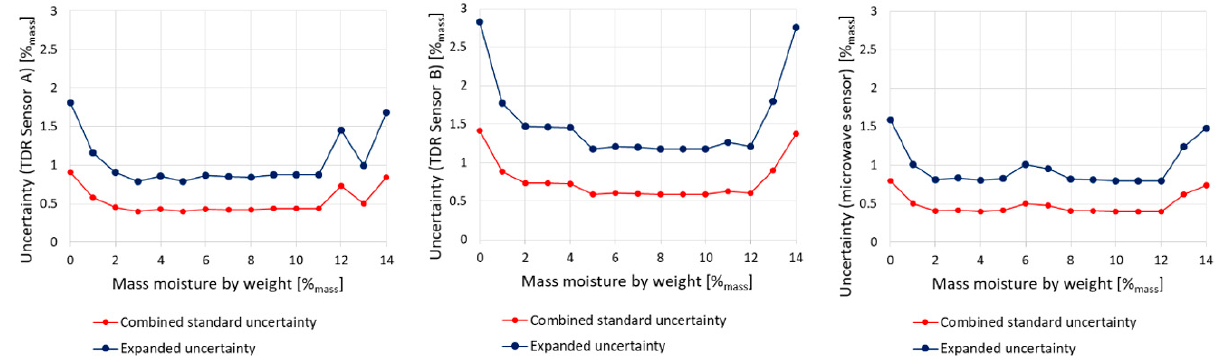
Figure 11. Distribution of combined standard and expanded measurement uncertainties for red brick and all tested sensors.